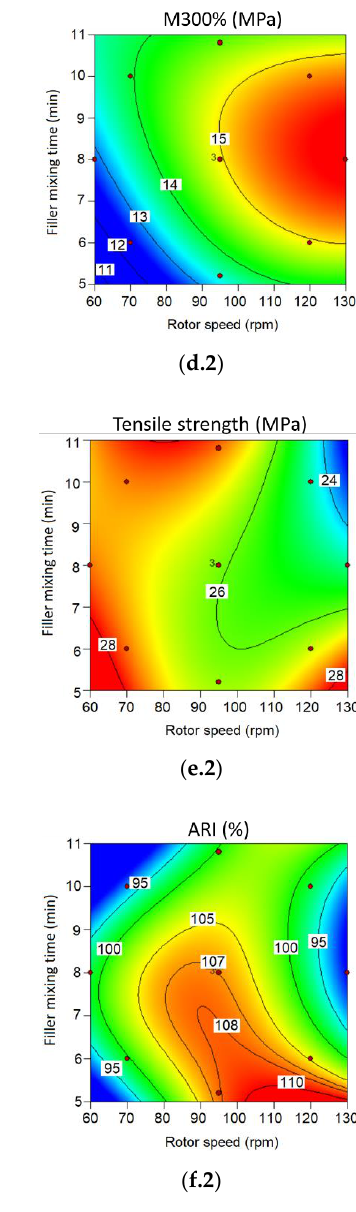
Figure 13. Response surfaces and contour plots of: ( a.1 ), ( a.2 ) Mooney viscosity (MV); ( b.1 ), ( b.2 ) Payne effect; ( c.1 ), ( c.2 ) tan delta; ( d.1 ), ( d.2 ) M300%; ( e.1 ), ( e.2 ) tensile strength; and ( f.1 ), ( f.2 ) abrasion resistance index (ARI).